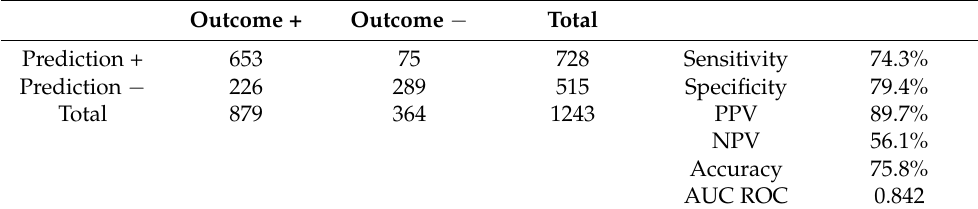
Table 2. Good clinical outcome AI predictions.